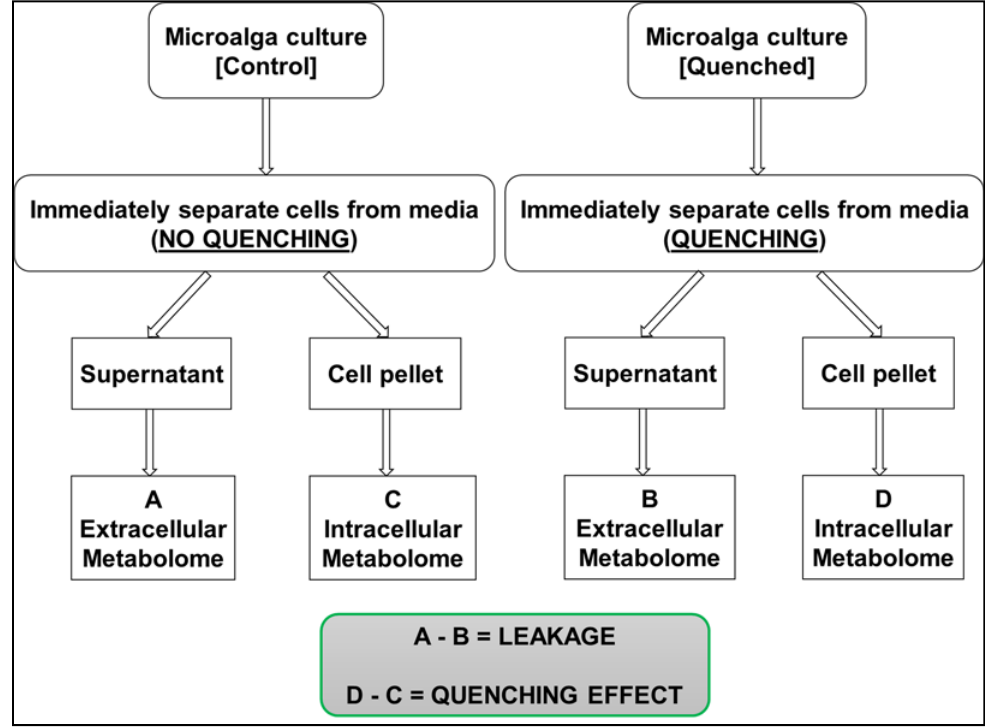
Figure 2. Schematic displaying the necessary correction required for appropriate calculation of intracellular metabolites after monitoring cell-free supernatant of quenched, non-quenched cells and the blank medium.